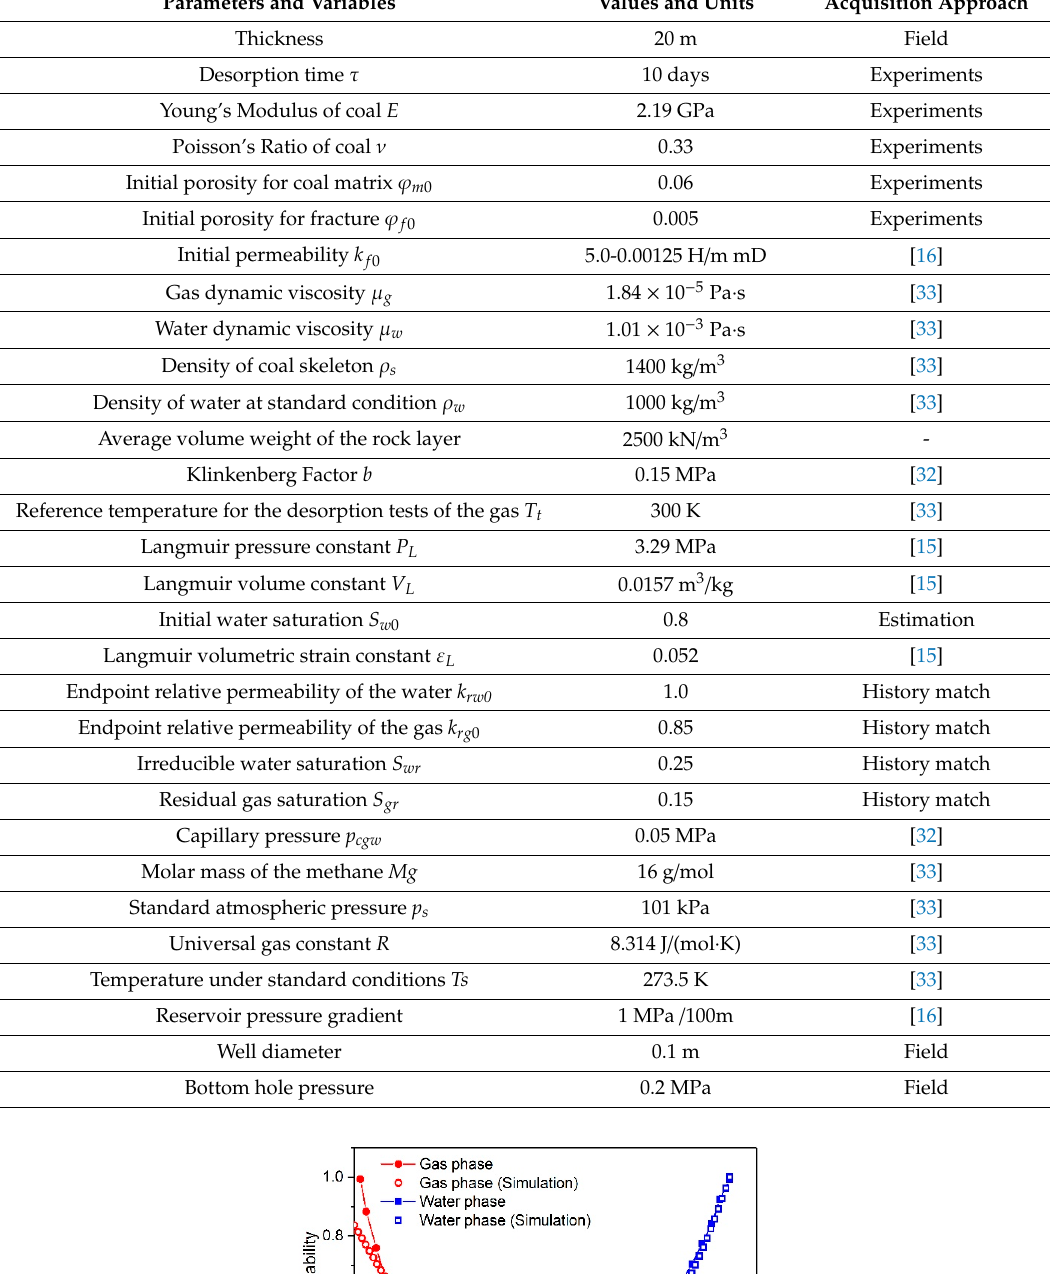
Table 1. Parameters of the numerical simulations.